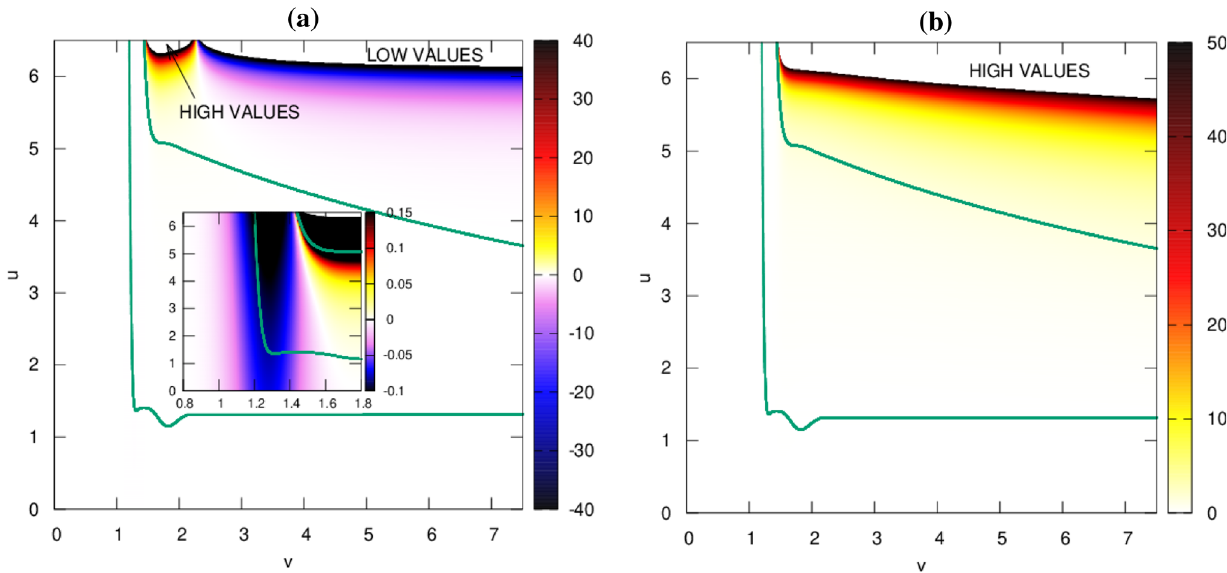
Fig. 18 The (v u ) -distribution of a the neutral scalar field, h , and b the moduli of the complex scalar field, | X | , for the same parameters and field amplitudes as in Fig.